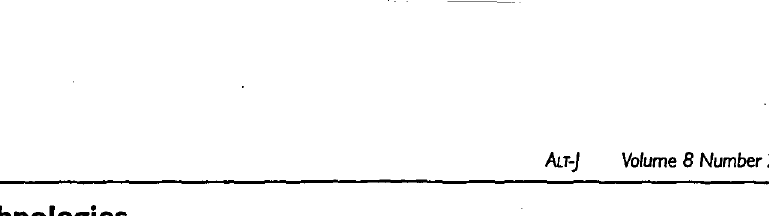
Figure 2: Screen-shot of a section of course material illustrating human ribonudease inhibitor (PDB code Ia4y), a protein which has an unusual 'alpha/beta horseshoe 1 structure. The inset shows the same protein displayed using the molecular viewer